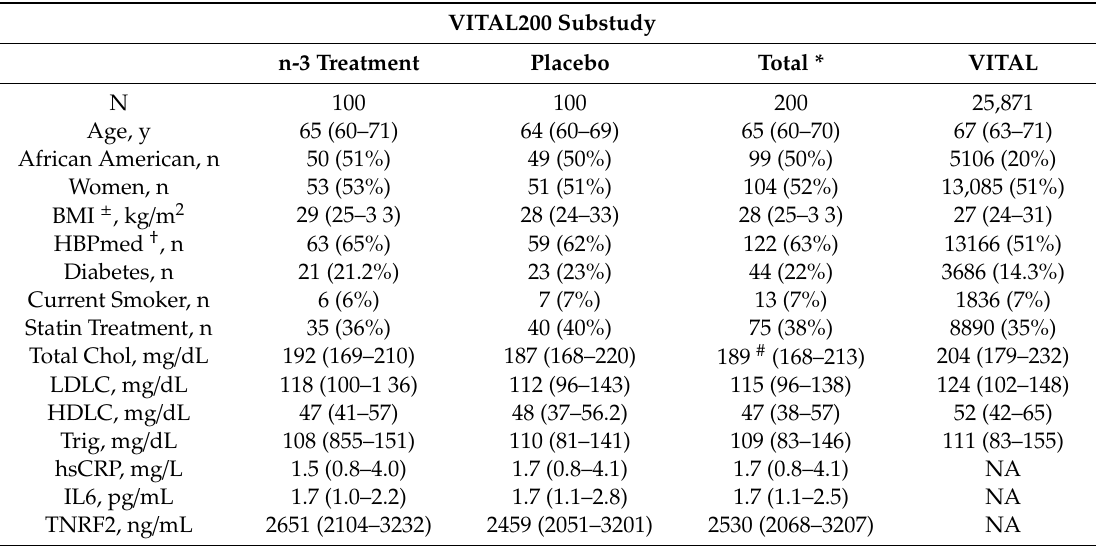
Table 1. Baseline demographic characteristics and clinical biomarkers in the Vitamin D and Omega-3 Trial (VITAL) and the Women’s Health Study